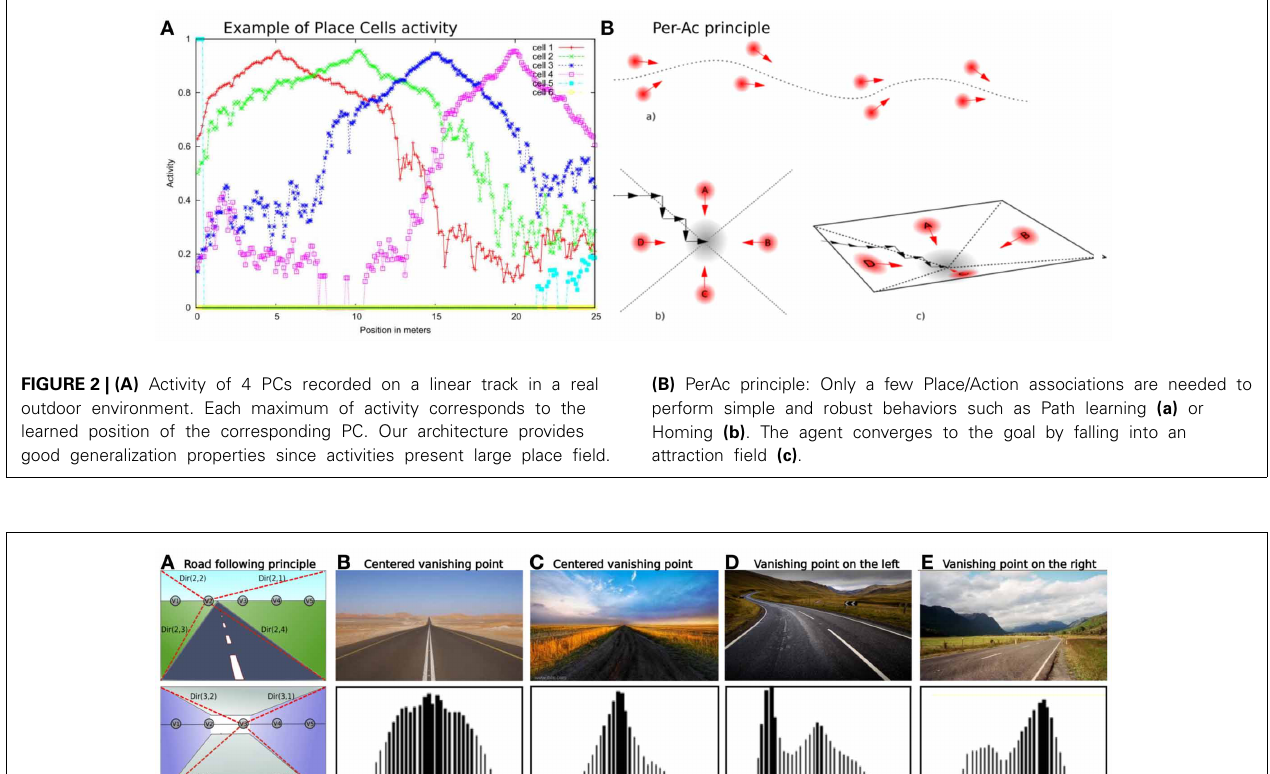
FIGURE 3 | (A) Road following principle for 5 vanishing point neurons (from V1 to V5) for outdoor and indoor cases (red dotted line: preferred directions of the winning neuron). Up: V2 is the best candidate. Down: V3 is the best candidate. (B–E) Results obtained with our algorithm on real images. For each cases: Up: real image of a road. Down: activity levels of 41 neurons, each one firing for a particular vanishing point location on the image. (B) Road with